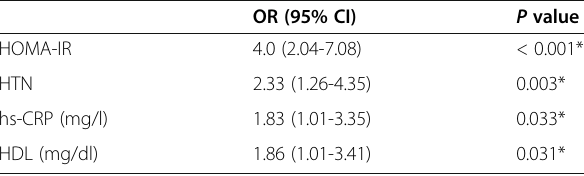
Table 3 Predictability of CAD severity [modified Gensini score] by different risk factors using multiple regression